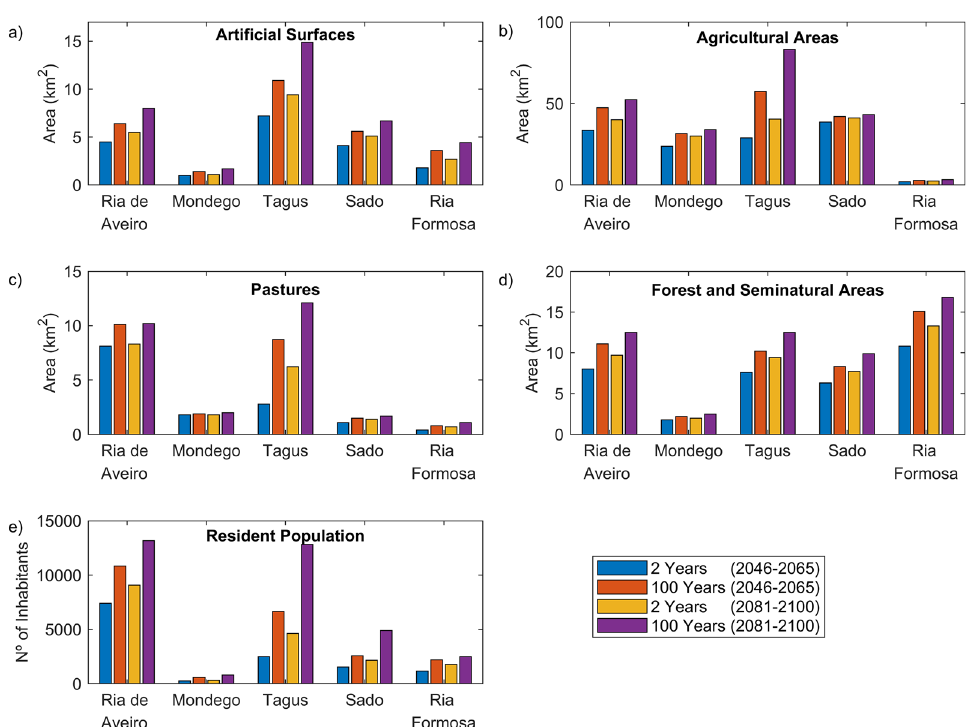
Figure 9. Inundation areas of different land uses: ( a ) Artificial surfaces; ( b ) Agricultural areas; ( c ) Pastures; ( d ) Forest and Seminatural areas. ( e ) Number of inhabitants directly affected by each inundation